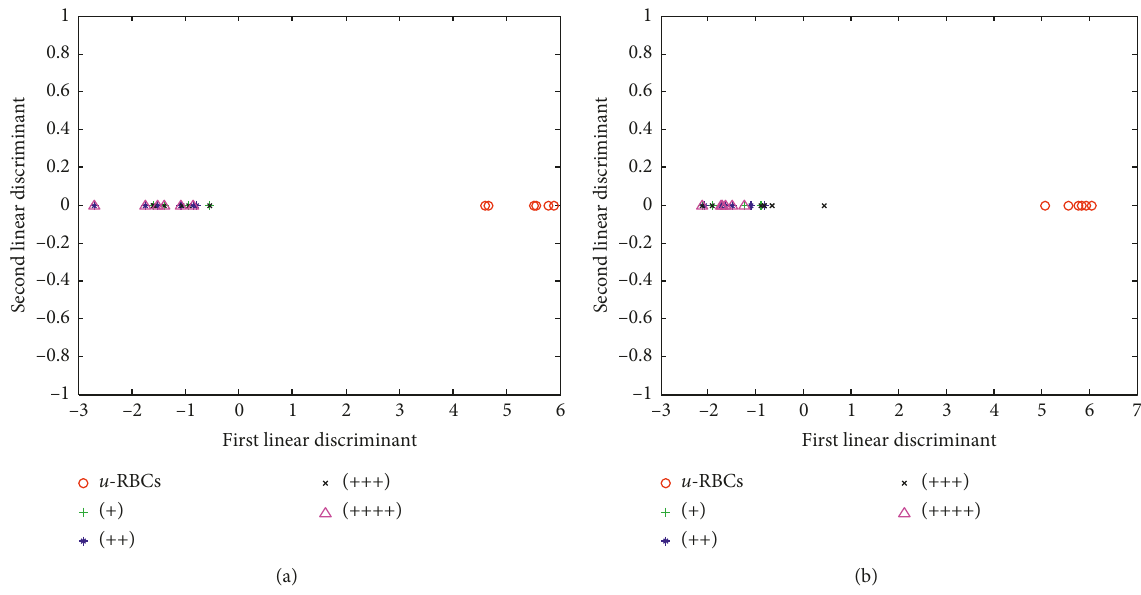
Figure 8: Scatter plots of first and second Fisher’s linear discriminants showing scattered pixel intensities of uninfected red blood cells ( u -RBCs) and Plasmodium falciparum -infected human red blood cells i -RBCs (+) with parasite density: (+), (++), (+++), and (++++) for (a) 435nm and (b) 660nm illumination light